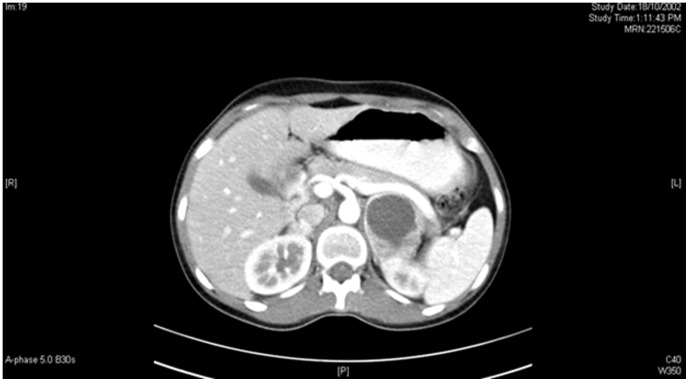
CT scan showing bilateral adrenal tumors.